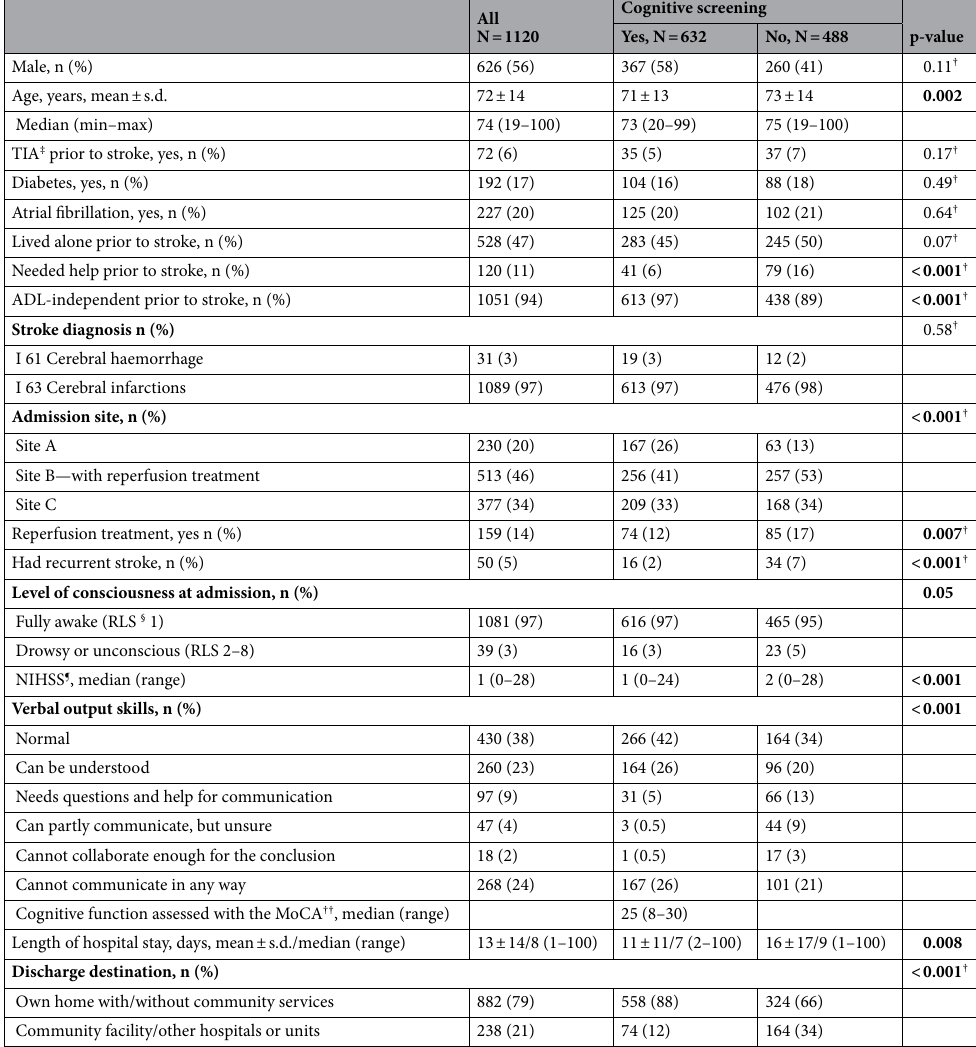
Table 1. Characteristics of the study participants (N = 1120). p-value: Statistical difference between the patients with (N = 632) and without (N = 488) cognitive screening; the bold text indicates statistically significant results. † Chi-squared test or Mann-Whitney U test. ‡ TIA transient ischemic attack, § RLS Reaction Level Scale, ¶ NIHSS National Institutes of Health Stroke Scale, †† MoCA Montreal Cognitive